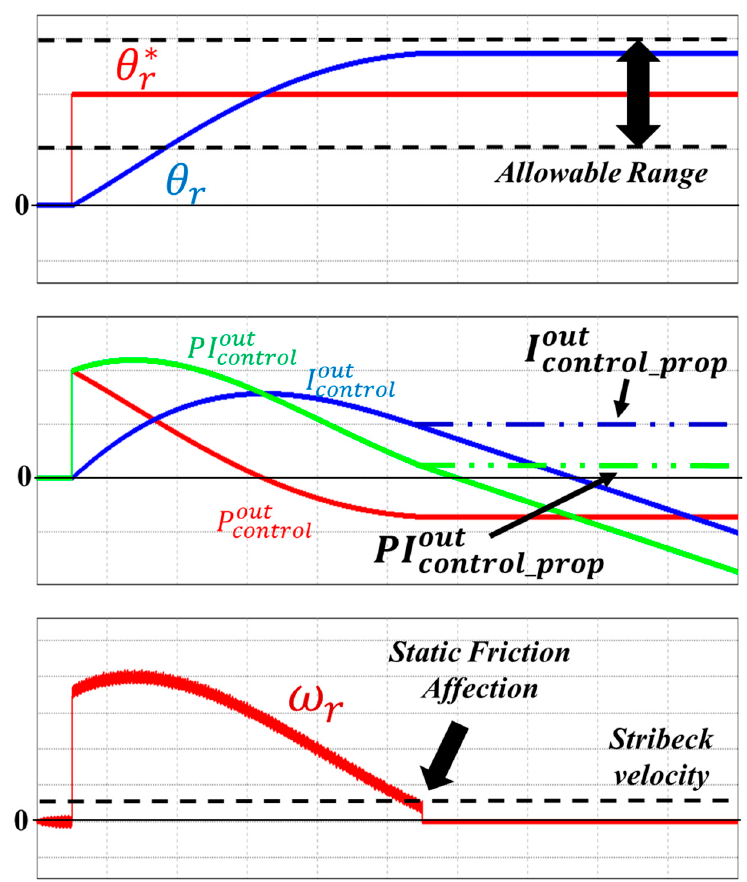
Figure 6. The operation of conventional and proposed PI controller.